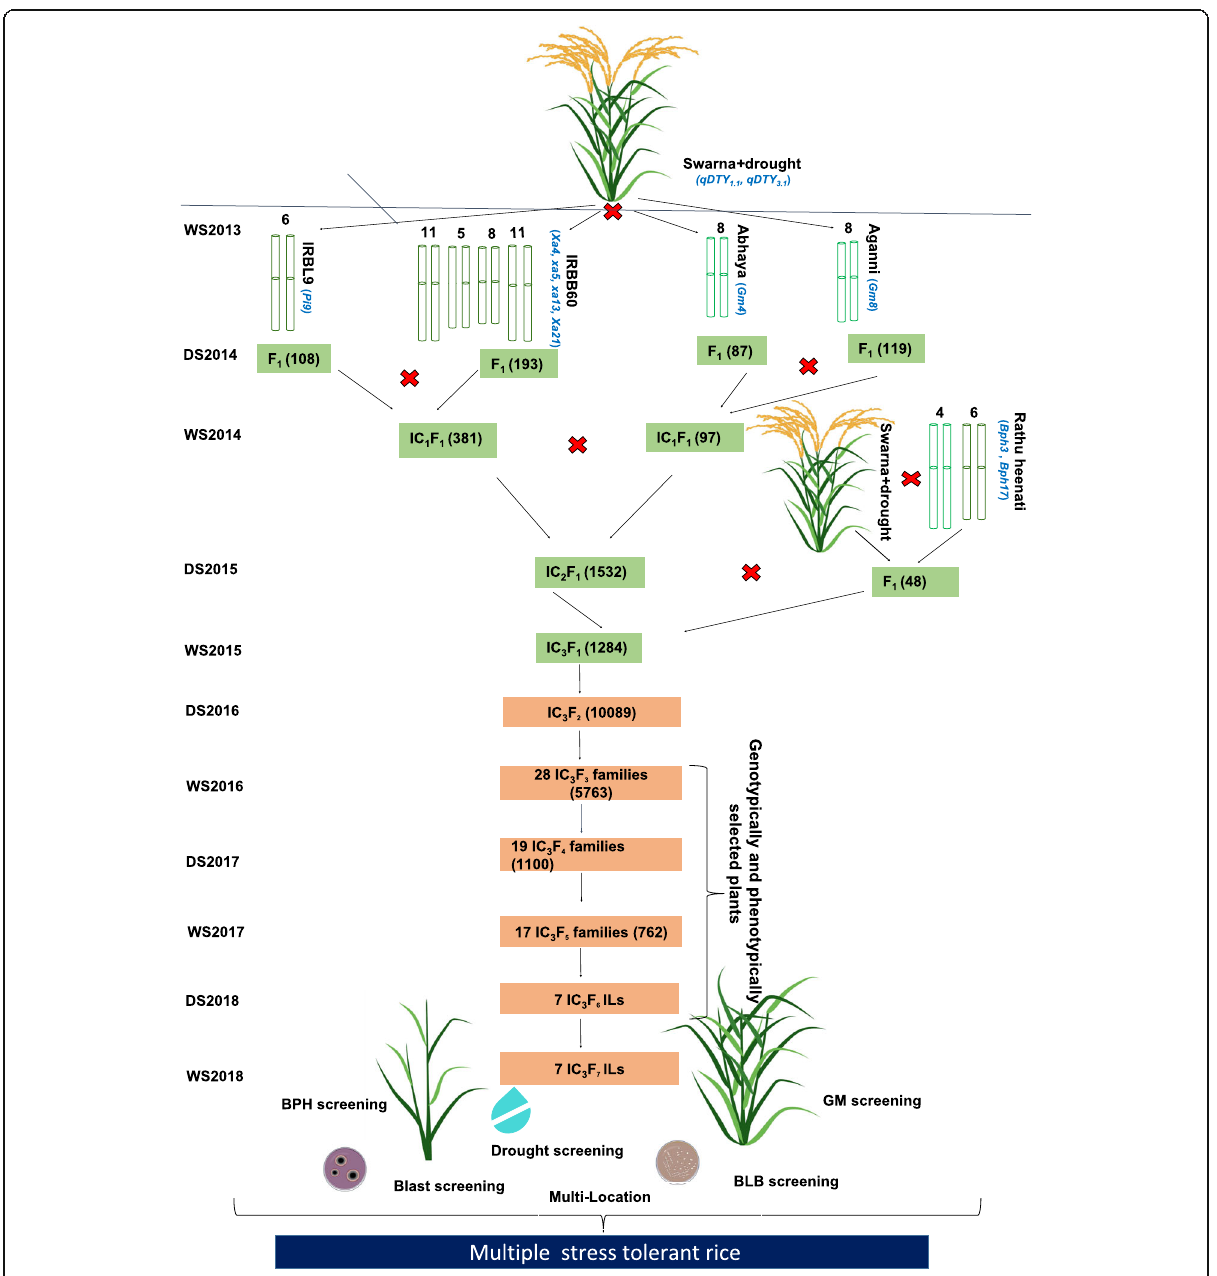
Fig. 1 Flow diagram depicting different steps of marker assisted forward breeding to combine multiple biotic-abiotic stress resistance/tolerance in rice Crossing program was initiated in WS2013 which involved crossing of recurrent parent (Swarna+drought, possessing drought tolerant QTLs namely ( qDTY 1.1 , qDTY 3.1 ) with four different donors possessing targeted genes or BB ( Xa4, xa5, xa13, Xa21 ), blast ( Pi9 ), BPH ( Bph3 and Bph17 ) and GM ( Gm4 and Gm8 ). The number over the chromosome represents the chromosome number of the respective donors. Through several rounds of inter-crossing, IC 3 F 1 with desirable QTLs/genes combinations were obtained in WS2015. Further, MAFB approach was utilized to combine genes/QTLs for BB, blast, BPH, GM and drought